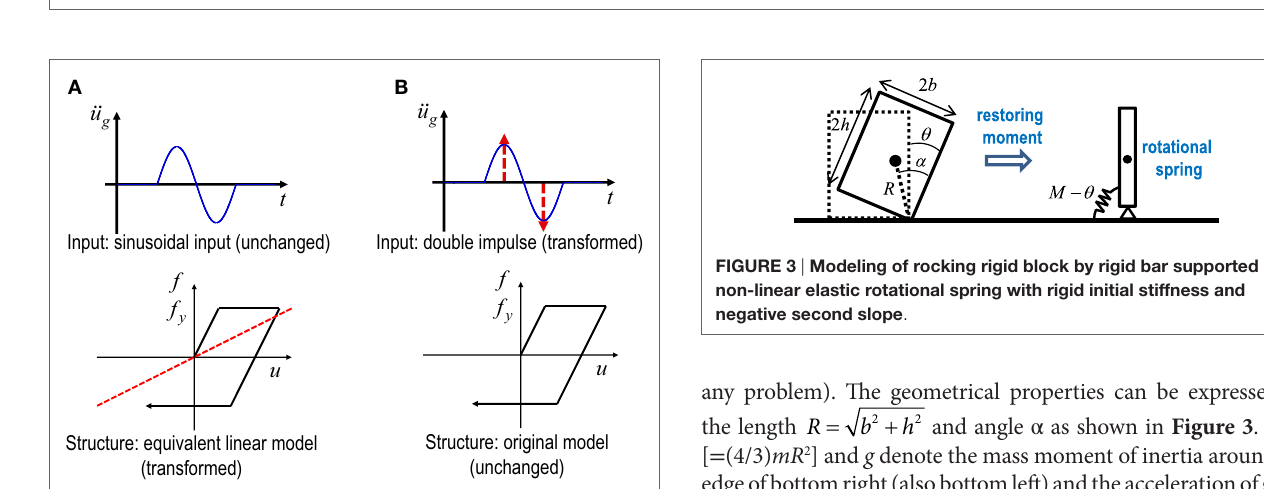
FigUre 1 | Modeling of principal part of near-fault ground motion into one-cycle sinusoidal wave and modeling of such one-cycle sinusoidal wave into double impulse .